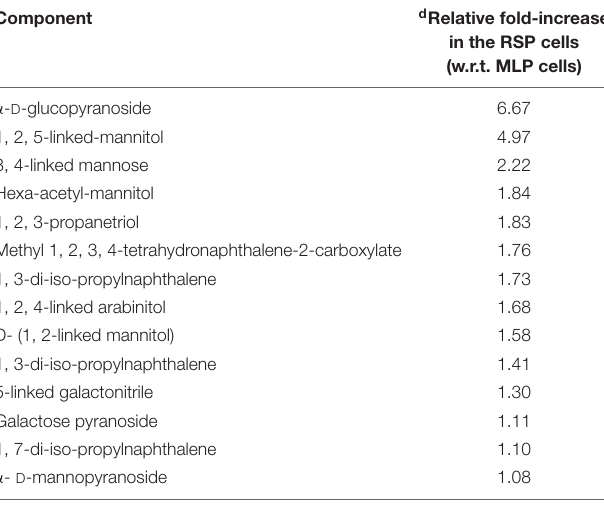
TABLE 1 | Relative abundance of the components of TCOL a in the cells from the rifampicin surviving population with respect to those of NCOL b in the MLP c cells, as analysed using